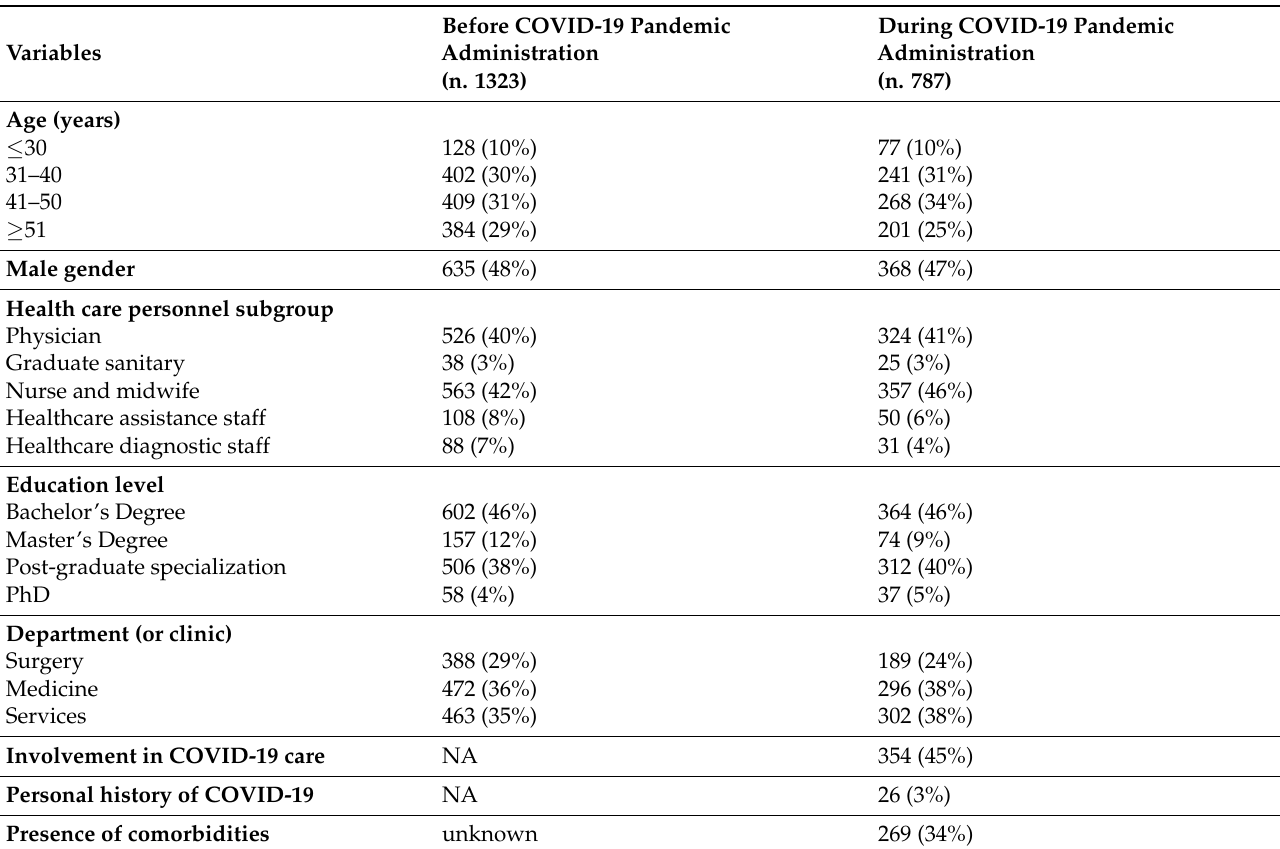
Table 1. Sociodemographic and working characteristics of participating HCP (Healthcare personnel) to the survey in the pre-pandemic and ongoing pandemic